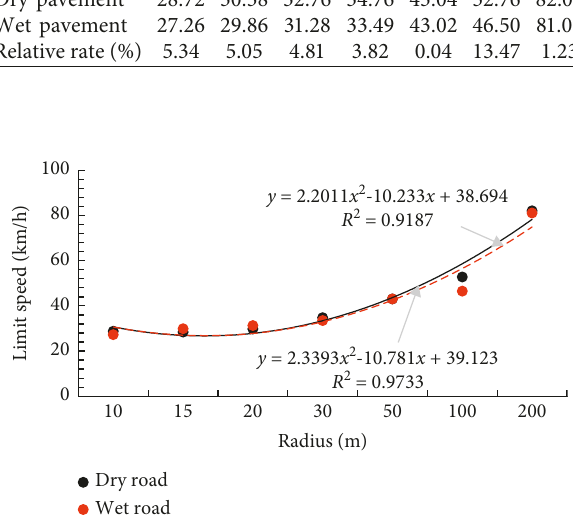
Figure 15: Speed limit curves under different road